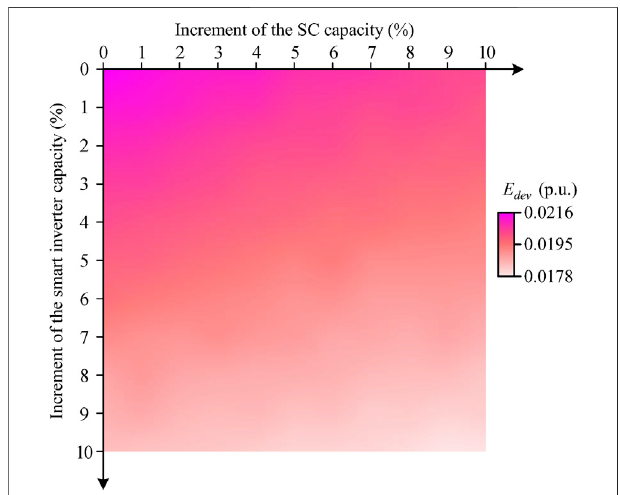
FIGURE 10 | Sensitivity